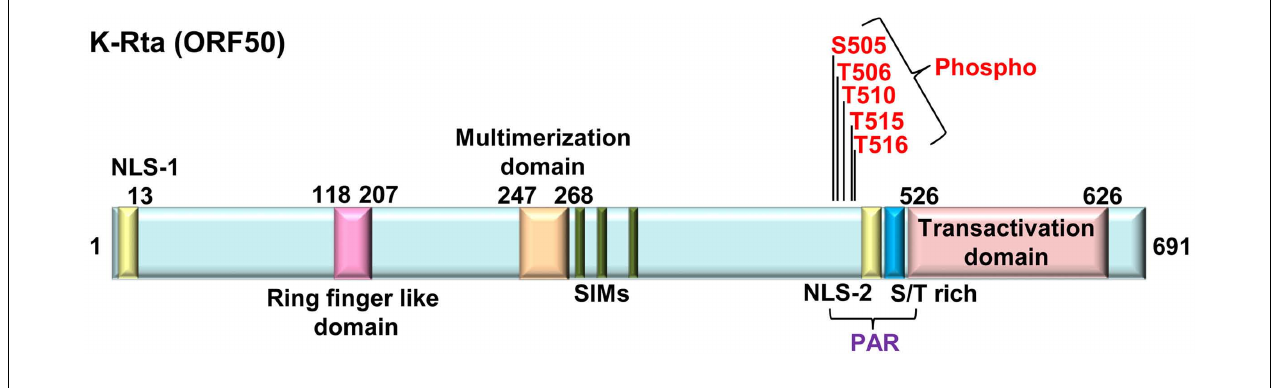
FIGURE 2 | Schematic representation of KSHV K-Rta. K-Rta protein and its post-translational modification sites as discussed in the text are depicted. Phosphorylation (Phospho) site numbering and PARylation (PAR) site localization of Gwack et al. (2003) is